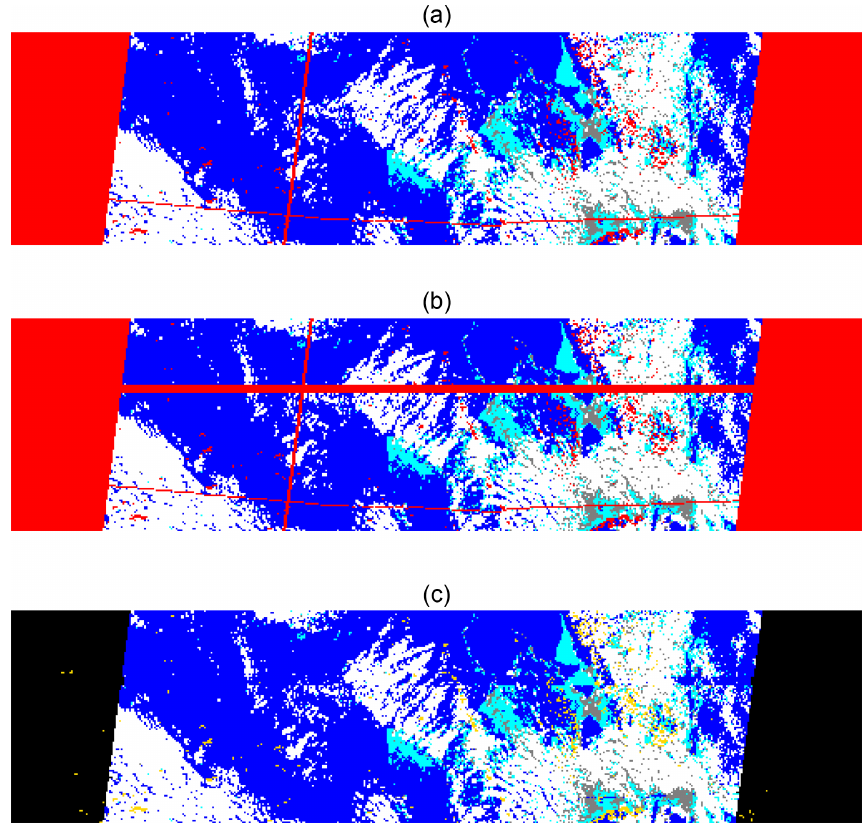
Figure 15. Maps of the RCCM for Path 168, Orbit 92981, Block 102 and camera DA. Linear dimensions are as described in the caption of Fig. 3, while color coding is identical to that indicated in Fig. 9. (a) Map of the original RCCM product, which natively contain missing data; (b) map of the artificially modified RCCM product, where lines 40 to 44 were declared missing; (c) map of the updated RCCM product, where all missing data have been replaced by estimates.